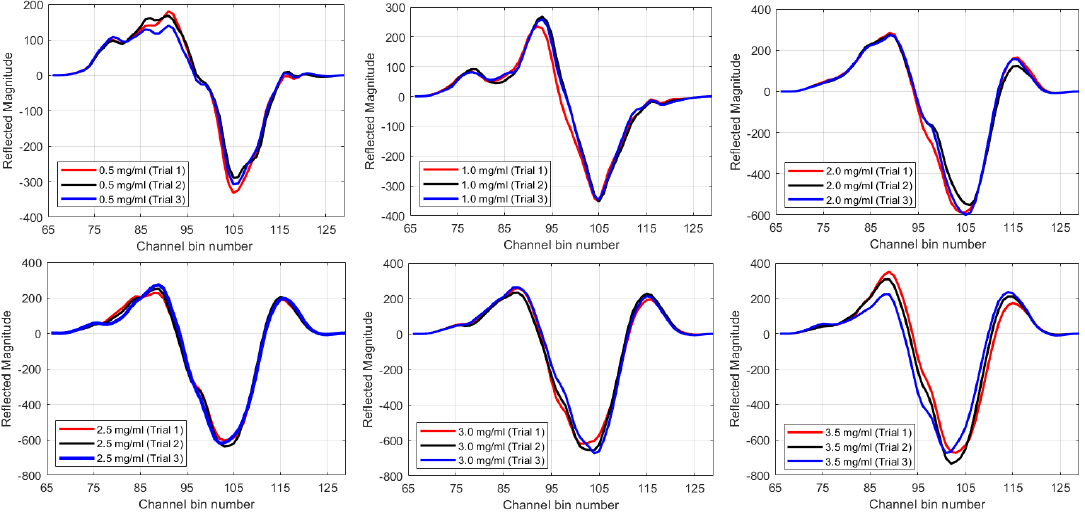
Figure 7. Raw data collected via radar channel 2 for glucose concentrations 0.5–3.5 mg / mL. Each subfigure shows the three measurement trials for each blood glucose concentration sample.